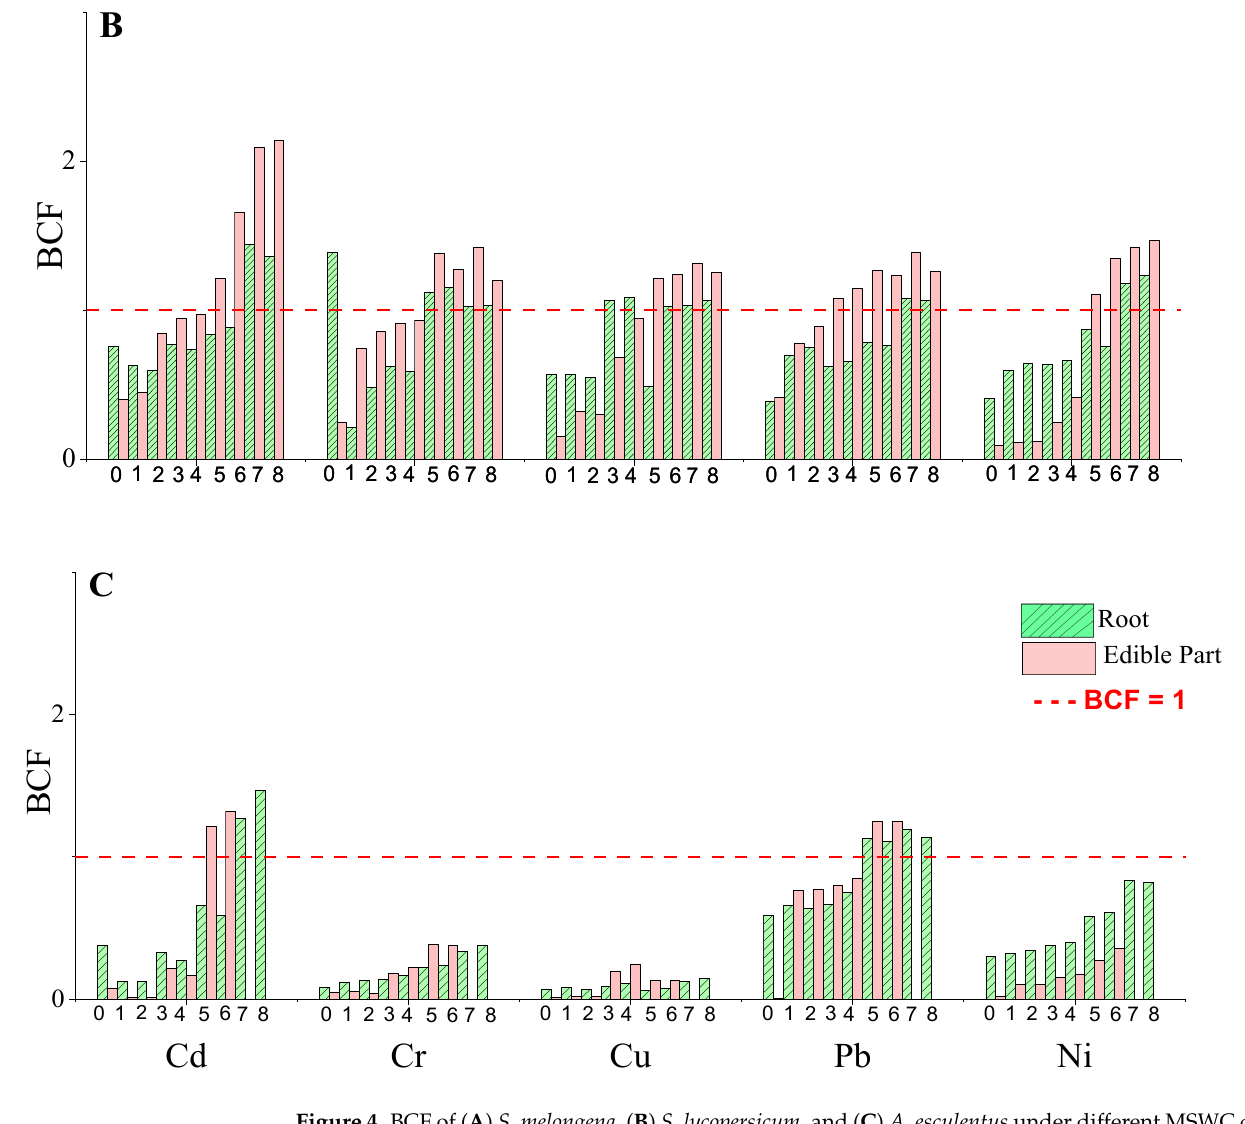
Figure 4. BCF of ( A ) S. melongena , ( B ) S. lycopersicum , and ( C ) A. esculentus under different MSWC concentrations, noted as 0(T0), 1(T1-B), 2(T1-O), 3(T2-B), 4(T2-O), 5(T3-B), 6(T3-O), 7(T4-B), and 8(T4-O).